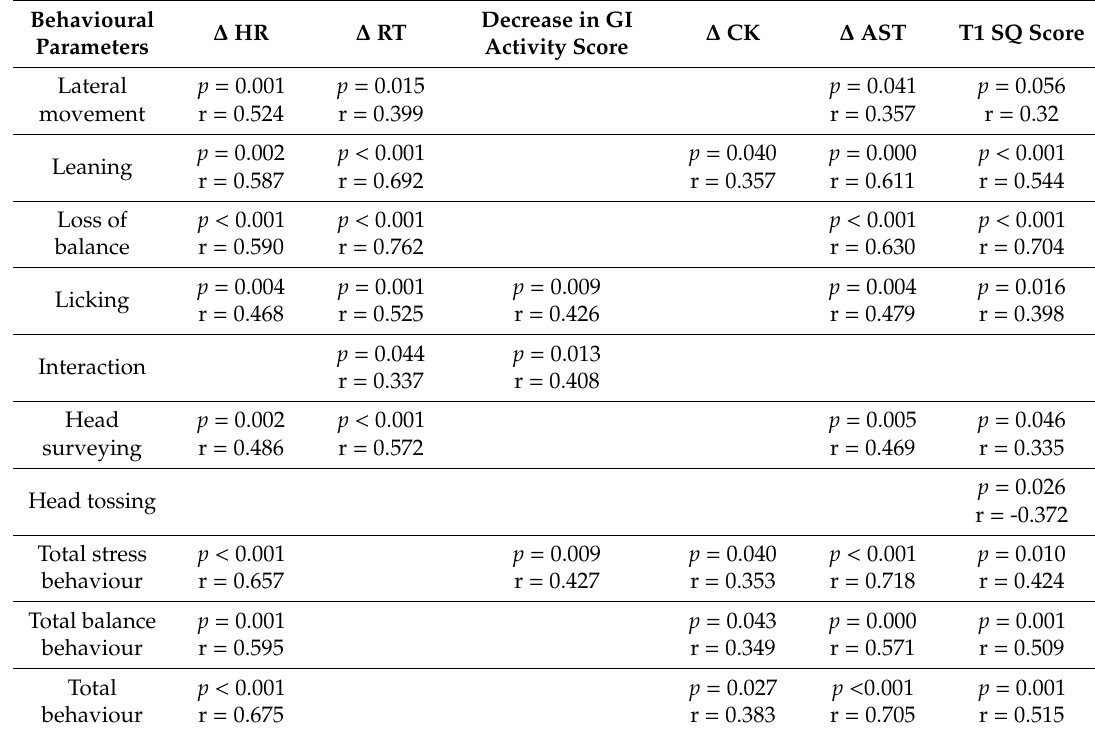
Table 4. Pearson correlations between the sum of the behavioural events recorded during transport and confinement, and observed changes ( ∆ , T1–T0) in heart rate (HR), rectal temperature (RT) GI activity scores, CK and AST concentrations, and summed squamous ulcer scores at T1 (after confinement / journey). Results are expressed as r- and p